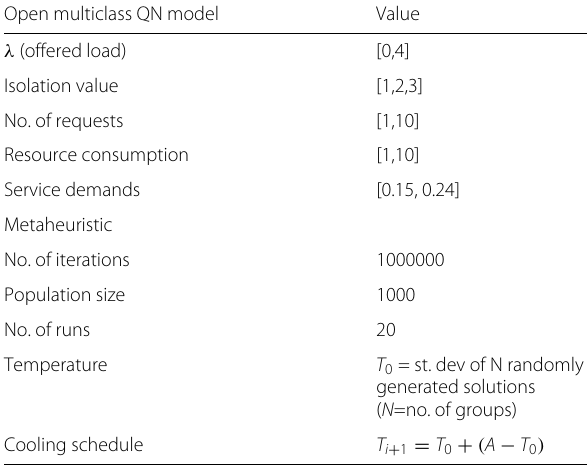
Table 3 Parameter values used in the experiments Open multiclass QN